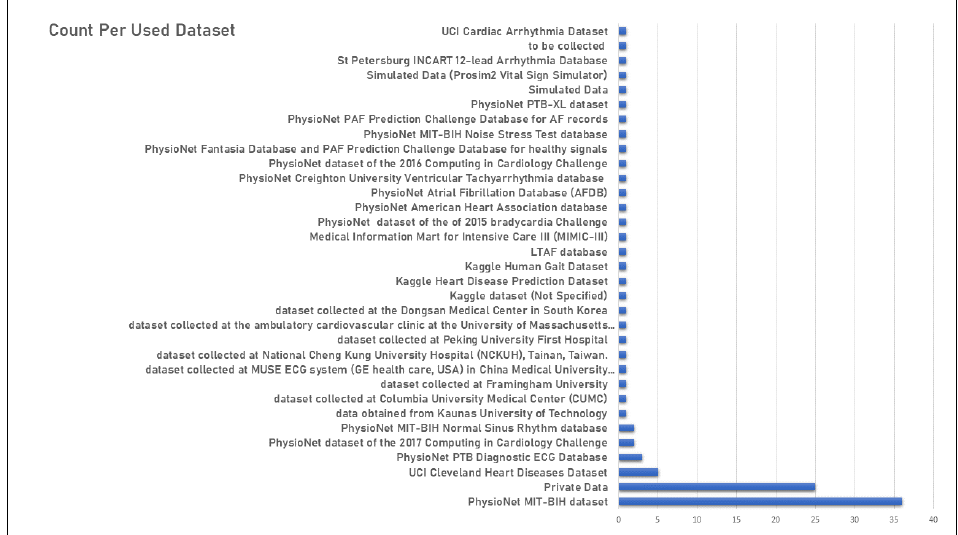
Figure 7. Training datasets in